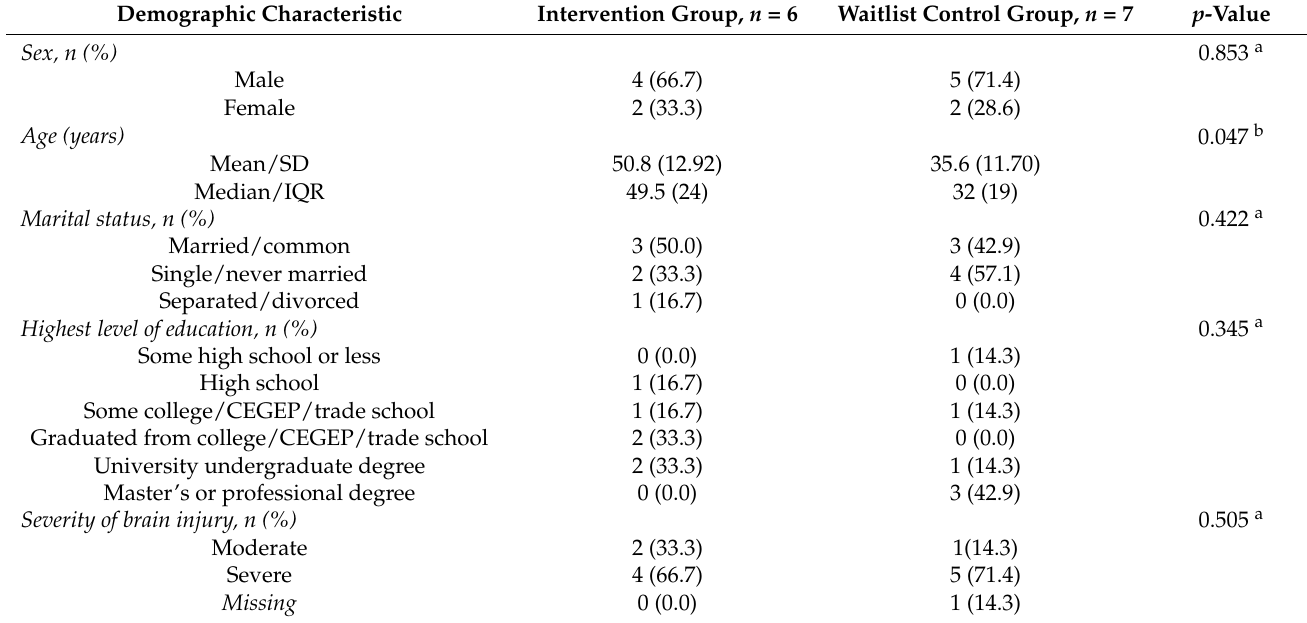
Table 1. Mentee demographic data and clinical characteristics at baseline.